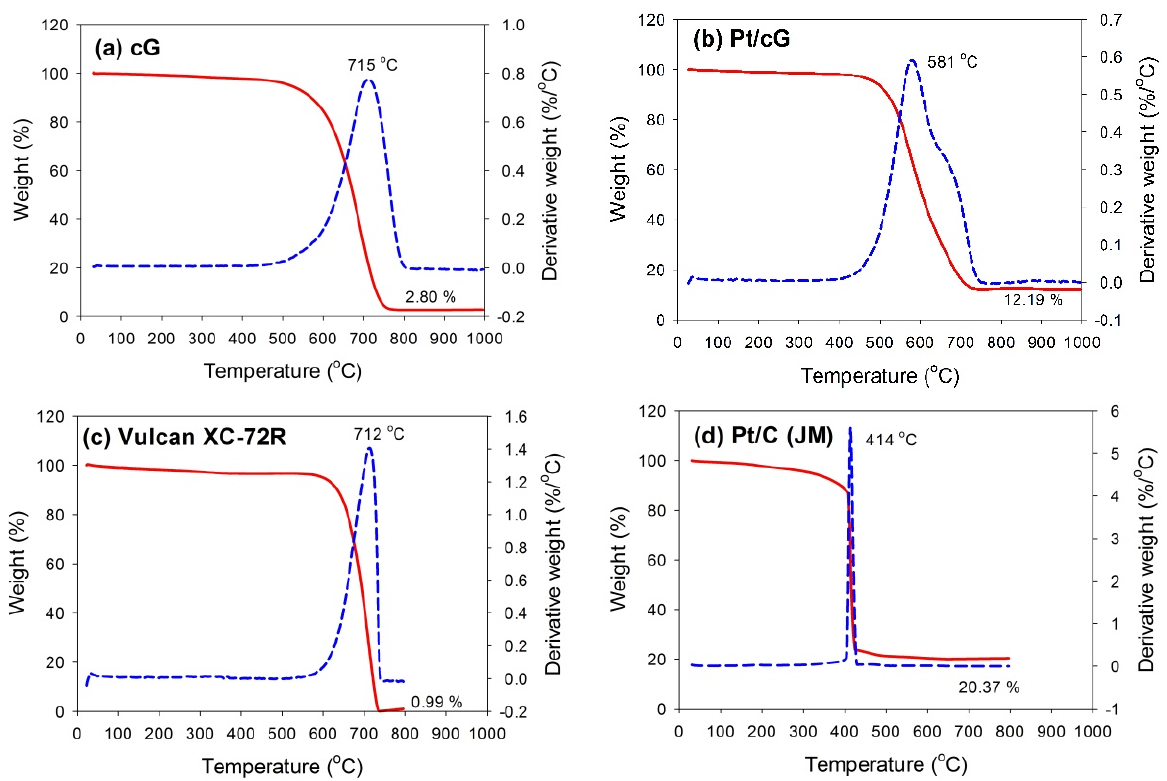
Figure 3. TGA profiles of the samples. ( a ) cG; ( b ) Pt/cG; ( c ) Vulcan XC-72R; ( d ) Pt/C